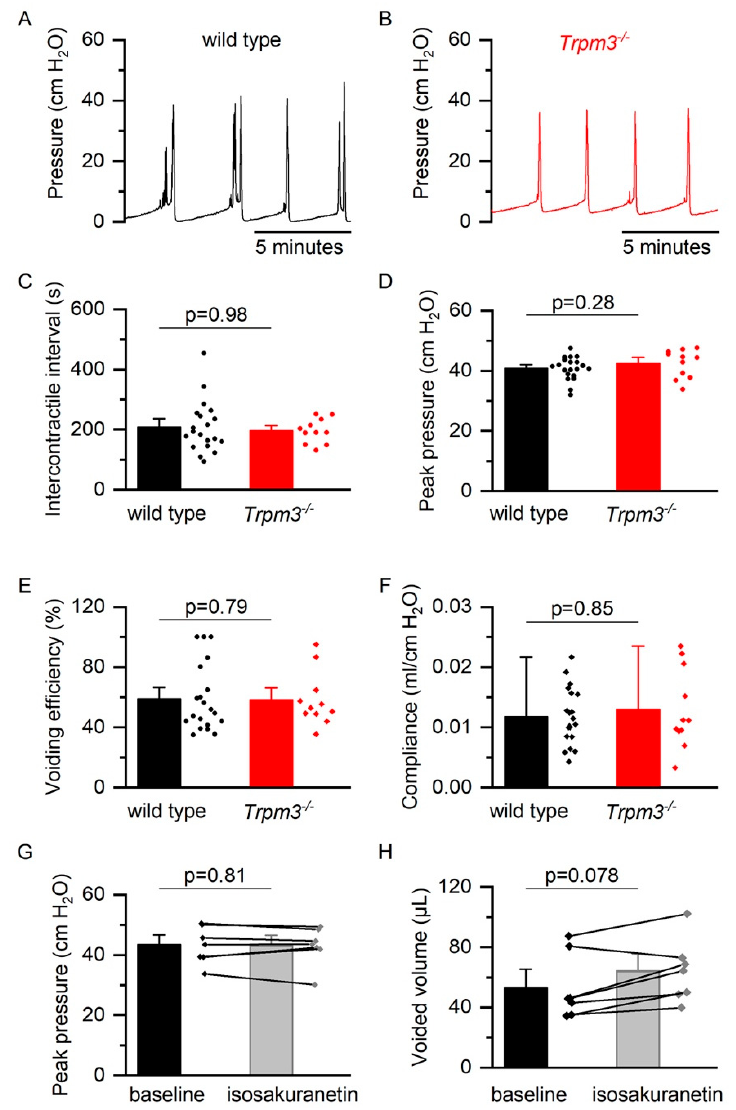
Figure 2. Cystometry in wild-type and Trpm3 -/- mice. ( A , B ) Representative examples of cystometry in a wild type (n = 20) and Trpm3 -/- ( n = 11) mouse during bladder filling at 0.02 mL/min. ( C – F ) Mean ( ± SE) intercontractile interval, peak pressure during voiding, voiding efficiency, and bladder compliance during cystometry in wild-type and Trpm3 -/- mice. ( G , H ) Peak pressure and voided volume during cystometry before and after intravesical isosakuranetin (10 mg/kg) administration in wild type mice.